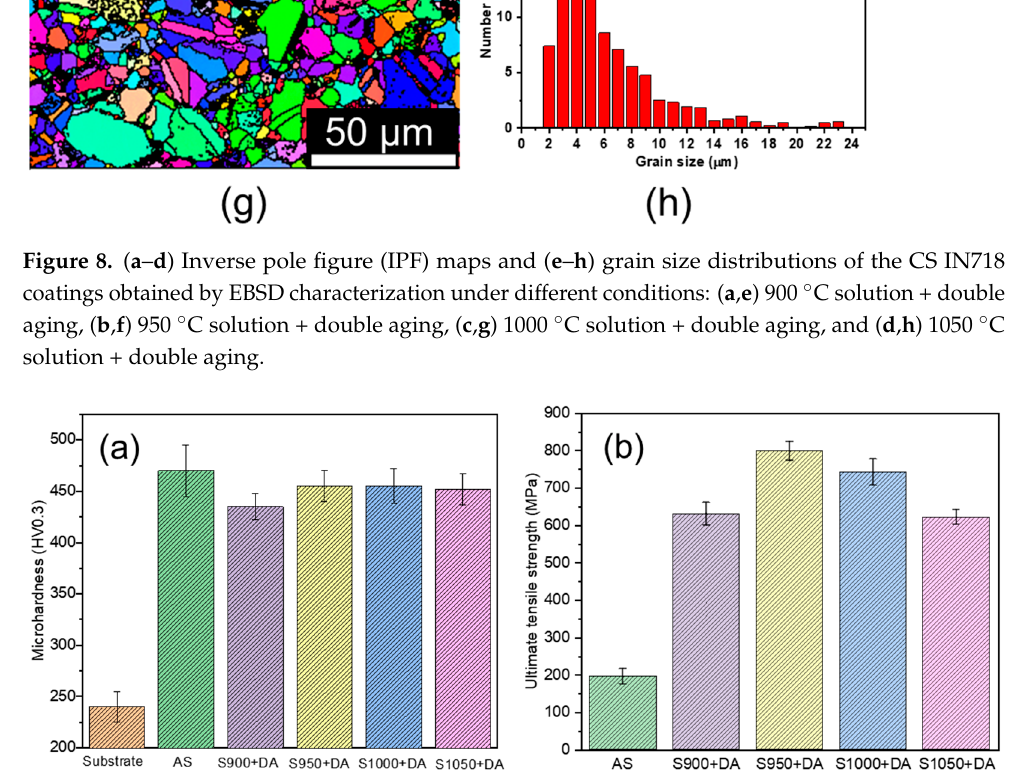
Figure 9. Vickers microhardness ( a ) and ultimate tensile strengths ( b ) of IN718 deposits in the as-sprayed and heat-treated conditions.